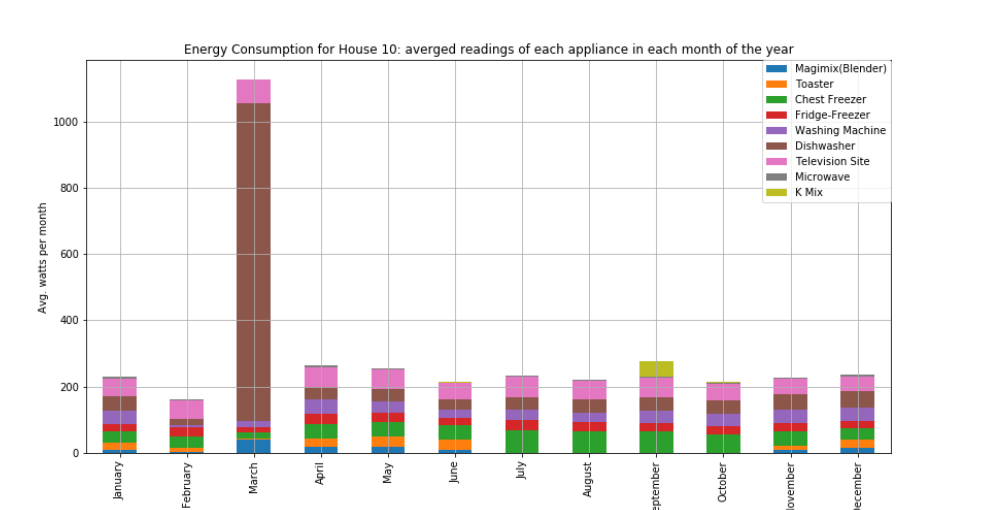
Figure A2. The average consumption per month of home appliances for house 10 with four occupants.